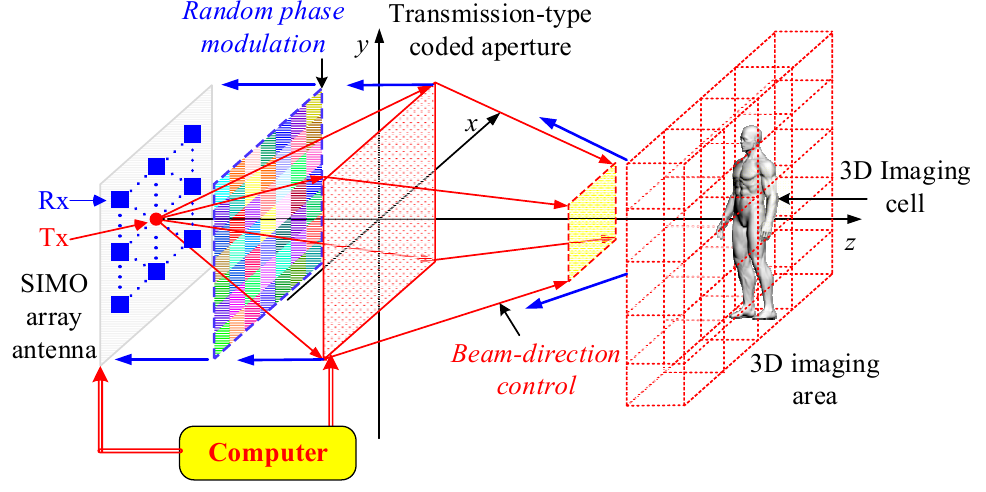
Figure 2. The TCAI architecture for close objects based on transmission coded-aperture.